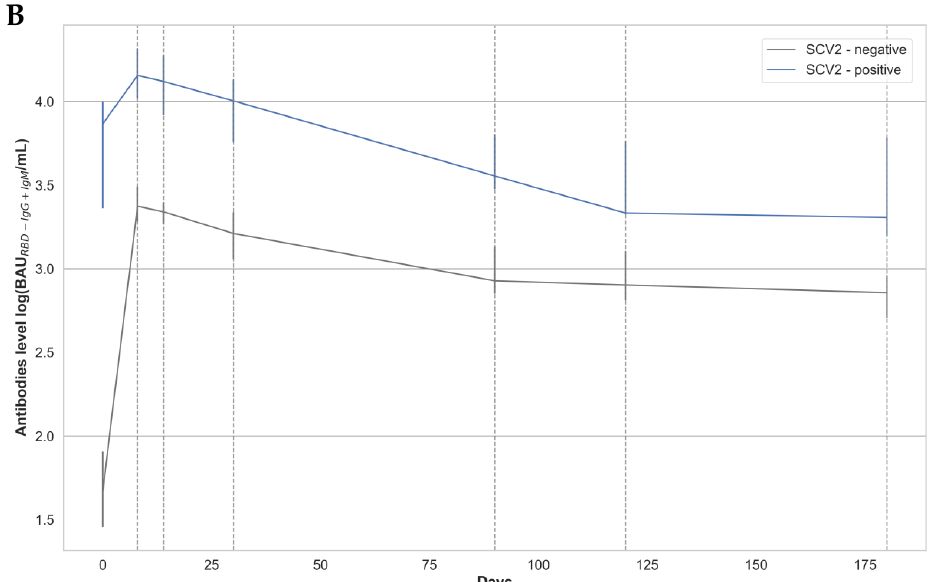
Figure 1. The logarithm value of median antibody levels ( A ) and the trend of changes of antibody levels ( B ) in the SCV2-negative and SCV2-positive groups, on different days, after the second dose of vaccine. For each box, the horizontal line inside the box shows the median. The ends of the box represent the 1st and 3rd quartiles, and the distance between them is called the interquartile range (IQR). The lower whisker end corresponds to a Q1–1.5 IQR value that is not an outlier observation; the upper whisker end, Q3 + 1.5 IQR, is expressed as the highest non-outlier observation. The number, the percentage of participants, and the mean antibody level of SCV2- negative and SCV2-positive groups after the second dose of vaccine, classified into groups: i) < 100 BAU RBD-IgG+IgM /mL; ii) 101 -1000 BAU RBD-IgG+IgM /mL; iii) 1000 – 2500 BAU RBD- IgG+IgM /mL; iv) > 2500 BAU RBD-IgG+IgM /mL, at different timelines, are presented in Table 2.